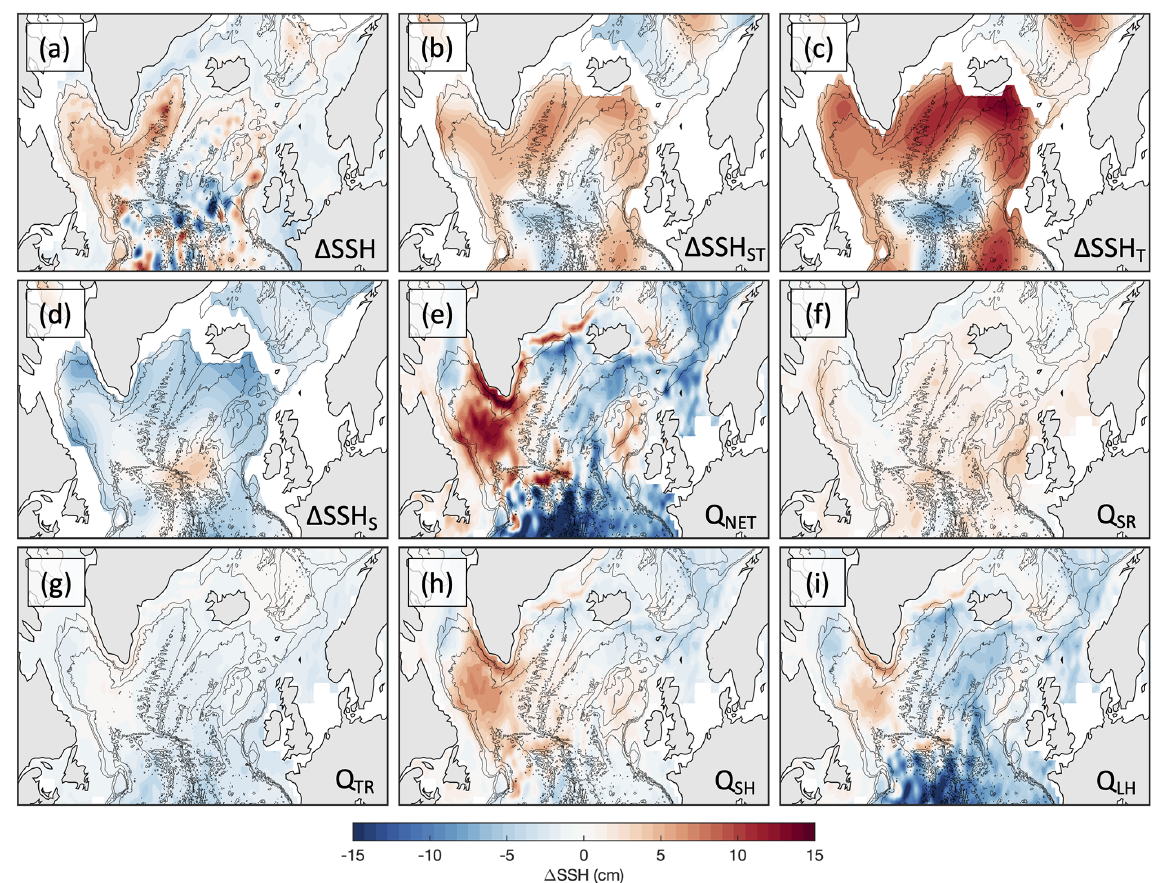
Figure 12. SSH change in 1994–2010: (a) total as observed with satellite altimetry ( (cid:49) SSH); (b) steric ( (cid:49) SSH ST ) , (c) thermosteric ( (cid:49) SSH T ) , and (d) halosteric ( (cid:49) SSH S ) as estimated from EN4 data; (e) due to the net surface heat flux ( Q NET ) , (f) due to the shortwave radiation ( Q SR ) , (g) due to the thermal (longwave) radiation ( Q TR ) , (h) due to the sensible heat flux ( Q SH ) , and (i) due to the latent heat flux ( Q LH ) as provided by the ERA5